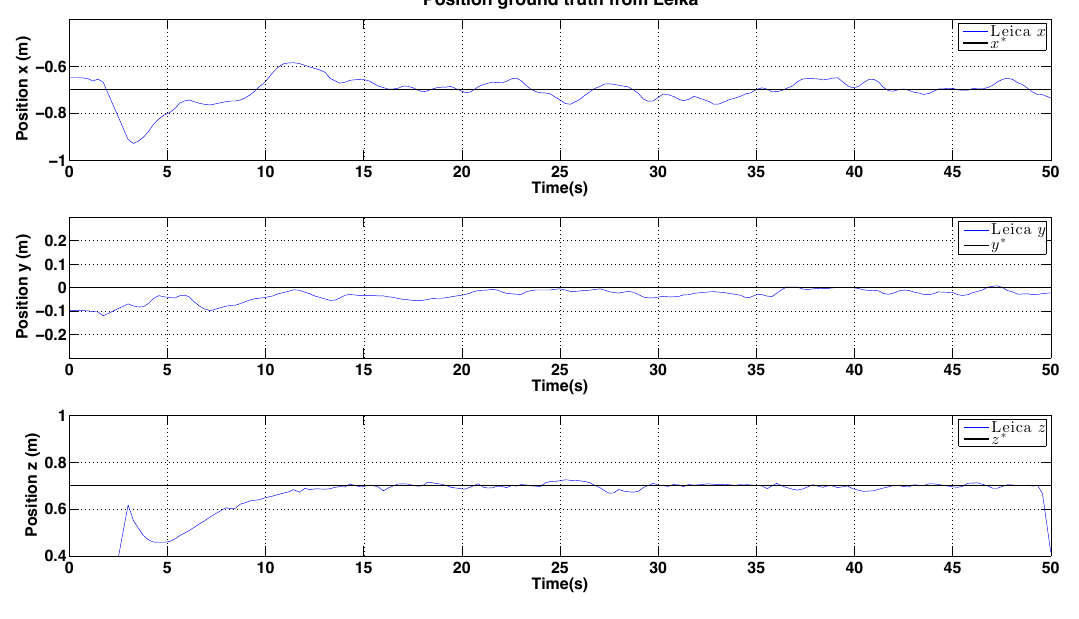
Figure 25. Experimental results for outdoor (day) PBVS-based hovering: control performance. Goal (black) and ground truth states (blue) . The desired position for W ˆ x , W ˆ y and W ˆ z is 0.7 m , 0 m and 0.7 m . We compute standard deviations of errors for each − state over the interval 10 s 50 s: σ = 0.038 m , σ = 0.028 m , and σ = 0.022 m x y z ∼